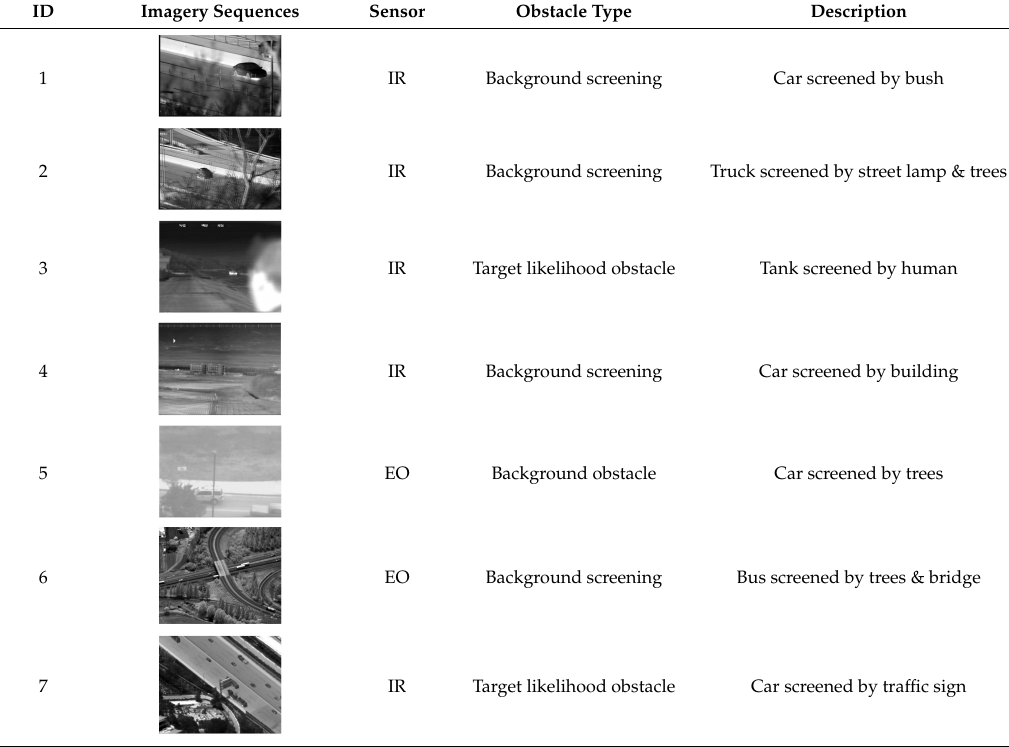
Table 1. Lists of the test imagery